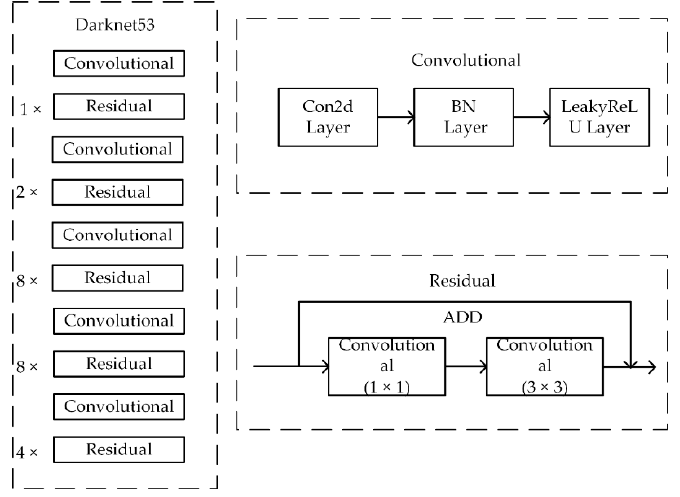
Figure 3. Darknet-53 network structure.